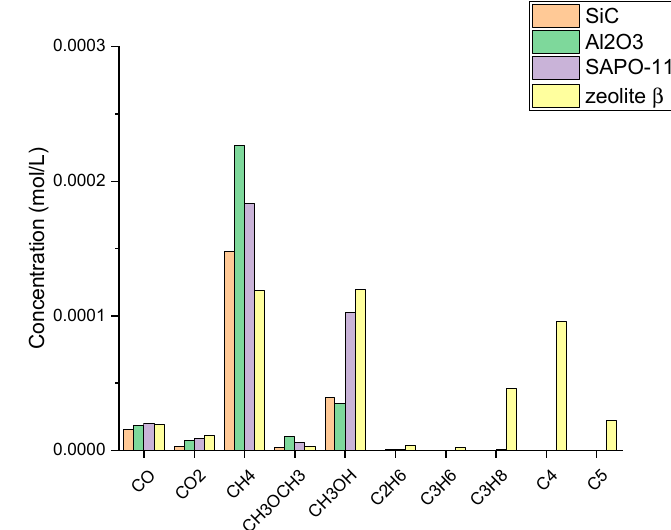
Figure 6. Concentration of gas-phase products of MP HDO over MoP / SiO 2 catalyst diluted with different materials (X MP = 100%). V cat = 1.8 cm 3 , LHSV = 10 h –1 , T = 290 °C, P H2 = 3 MPa, H 2 /feed = 600 cm 3 /cm 3 .